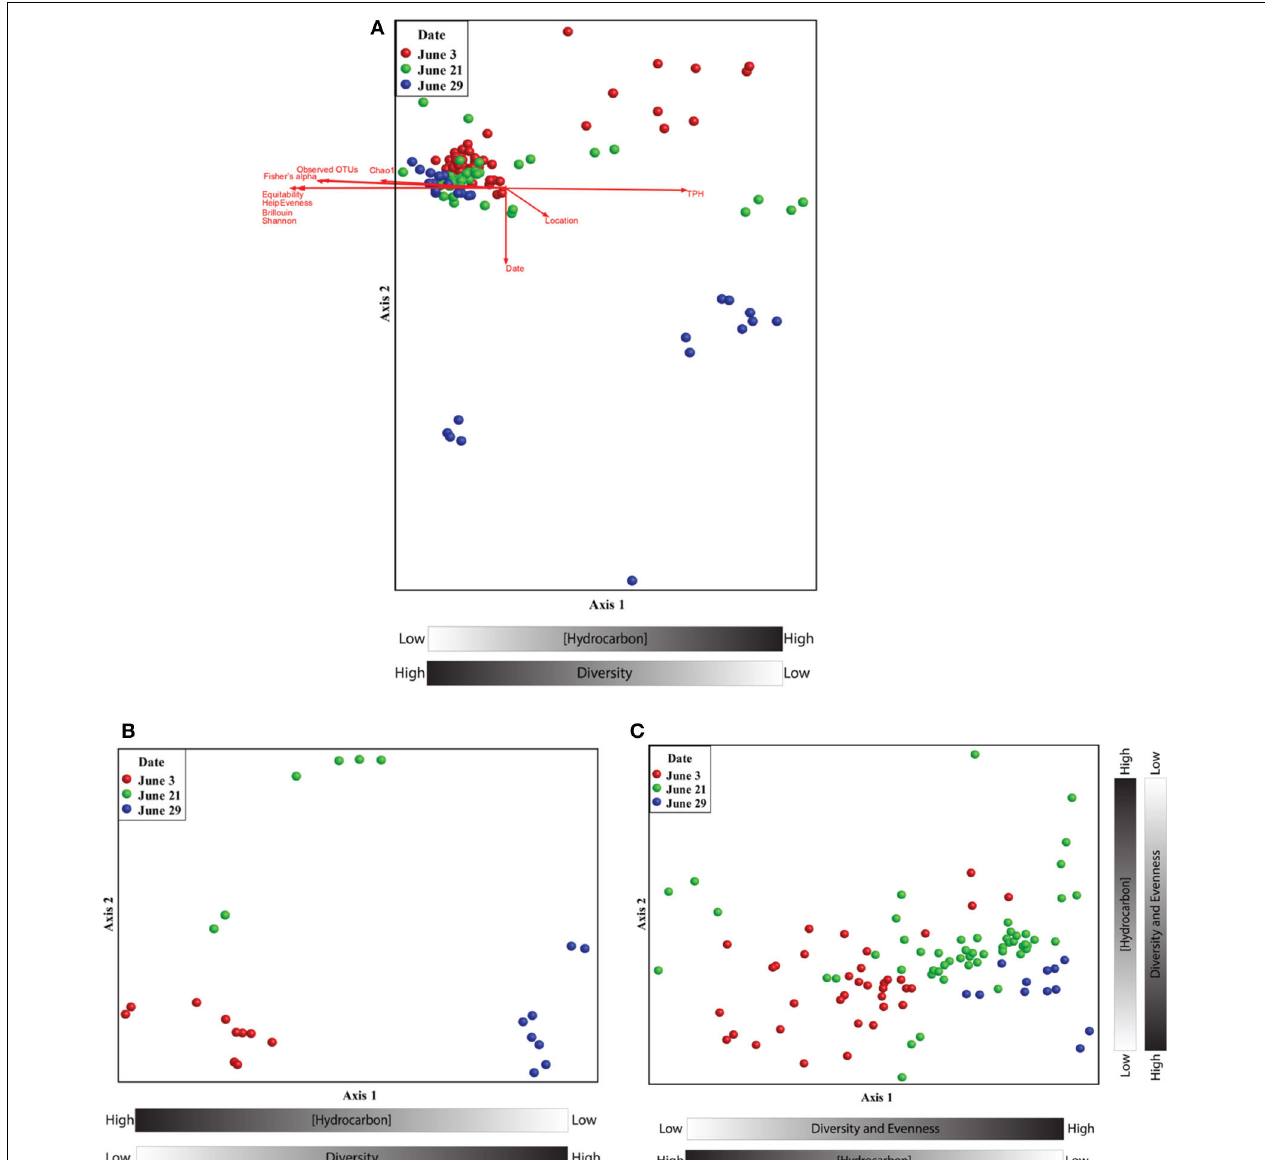
FIGURE 2 | (A) Non-metric multidimensional scaling ordination of beached oil and sand samples based on the relative abundance pyrotag sequences assigned to family-level taxonomy. The ordination plot was rotated to maximize the degree of correlation with the total petroleum hydrocarbon variable. A two dimensional solution was found and the final stress was 0.023. (B) Non-metric multidimensional scaling ordinations of beached oil based on the relative abundance pyrotag sequences assigned to family-level